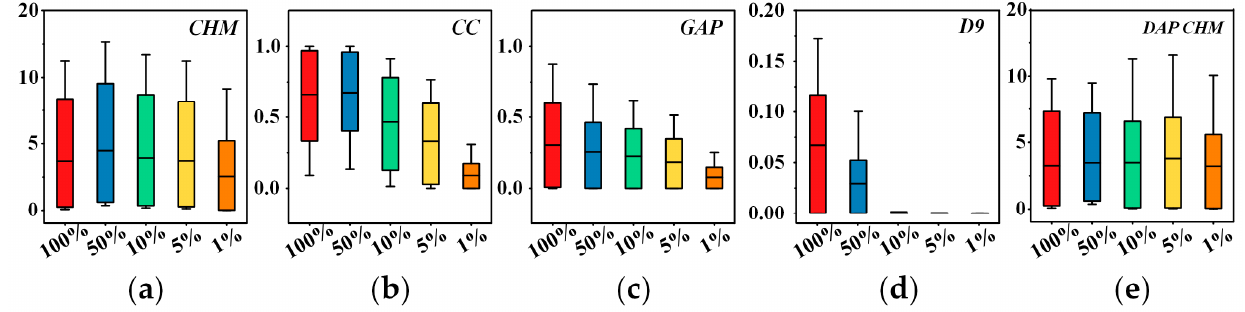
Figure 8. Variations of the LiDAR and photogrammetric features with reduced point densities: ( a – d ) LiDAR features; ( e ) photogrammetric features.